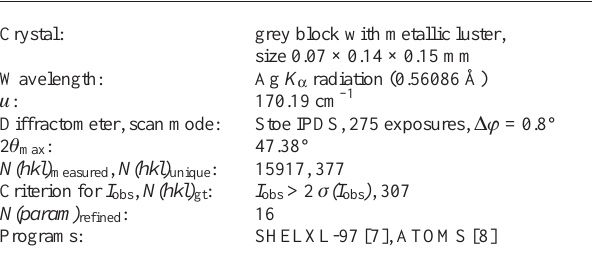
Table 5. Data collection and handling.